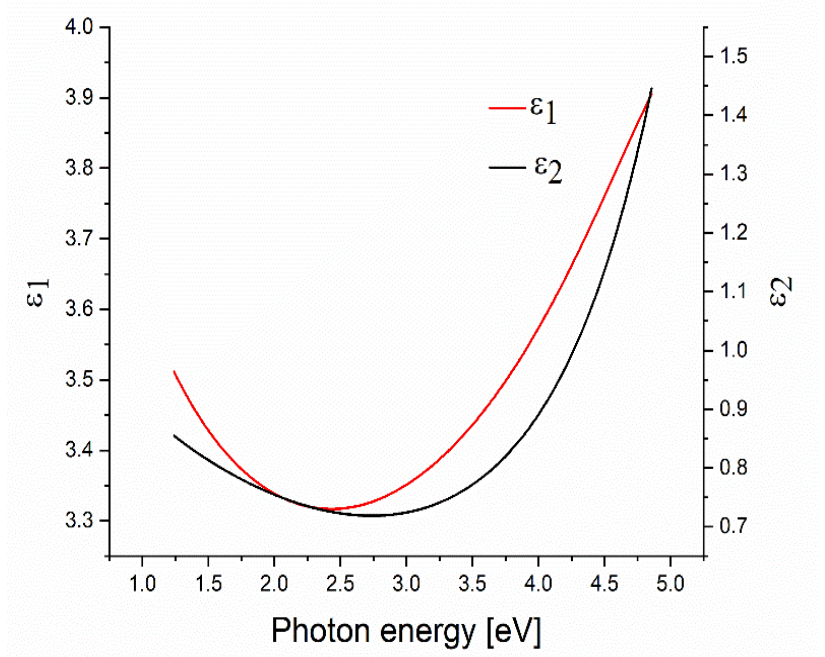
Figure 5. Estimated dispersion laws of RGO films on glass substrates by ellipsometry characterization. The solid curves represent the real (red curve) and the imaginary (black curve) part of the dielectric constant.